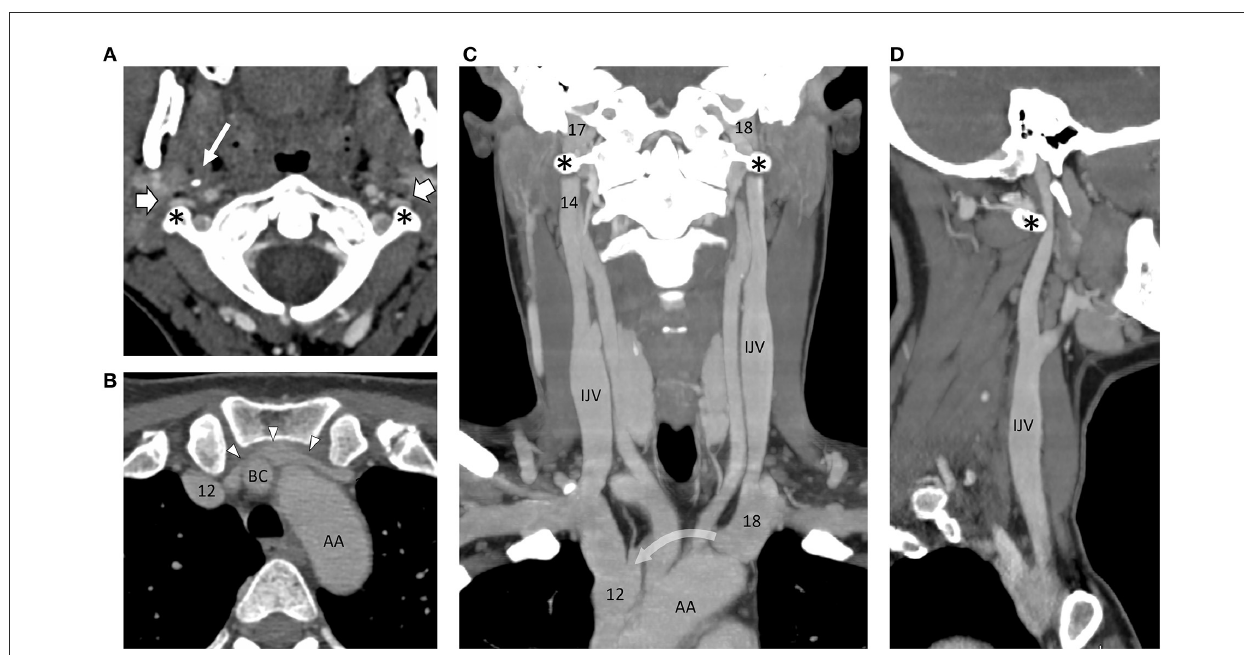
FIGURE1 Montage of CT images following intravenous contrast, outlining the arterial and venous angioarchitecture of the neck. (A) Axial slice through the C1 vertebra and odontoid peg show the narrowing and flattening of both internal jugular veins (block arrows) as they pass in front of the transverse processes of C1 (asterisks) on either side. The styloid process of the skull (thin arrow) can be seen on the right side. The internal carotid arteries are round in cross-section and situated more medially. (B) Axial slice through the thoracic inlet at the level of the left brachiocephalic vein (arrowheads) showing marked narrowing in front of the right brachiocephalic artery (BC, right brachiocephalic artery; AA, aortic arch). (C) In this coronal reconstruction, the internal jugular veins (IJVs) lie on the lateral side of the carotid arteries. They are out of the plane as they pass over the C1 transverse processes, but on the sagittal reconstruction (D) , the distortion produced on the left side is evident (curved arrow = path of the left brachiocephalic vein, out of the plane in front of the left common carotid and right brachiocephalic arteries.). Numbers are transposed from pressures (cm H 2 O) recorded on catheter